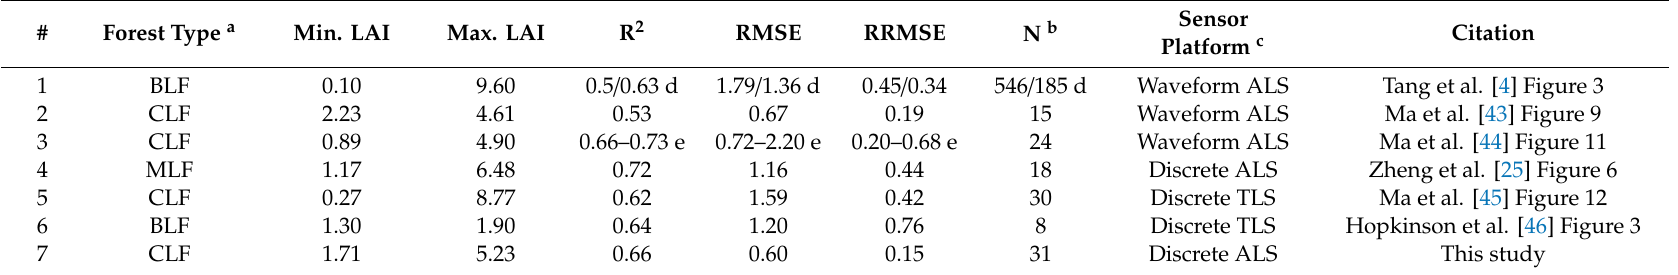
Table 3. Performance of LiDAR-derived LAI of di ff erent physically-based methods * . RMSE: root mean square error; RRMSE: relative